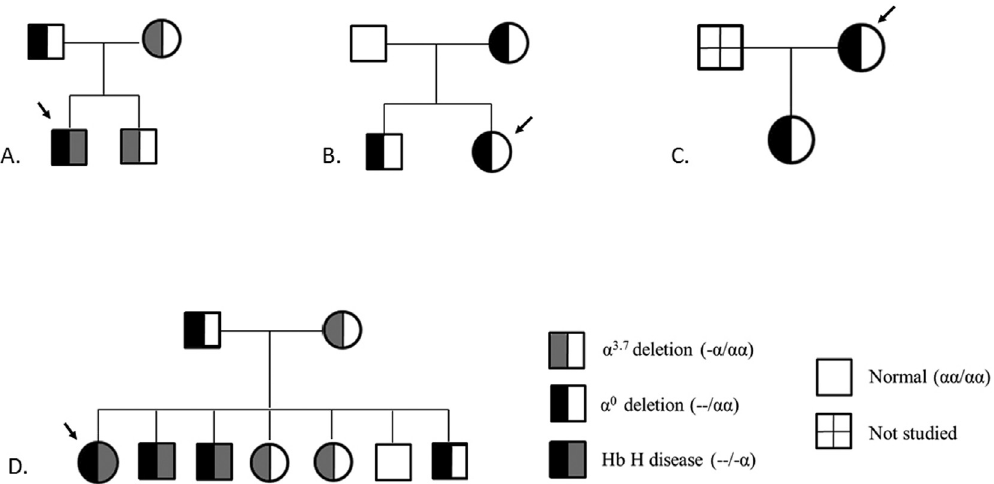
Figure 2 - Pedigrees of the families studied. (A) P1 has Hb H disease (- (cid:2) 3.7 and (cid:2) 0 alleles), while his mother and brother are heterozygous for the - (cid:2) 3.7 de- letion and his father for the (cid:2) 0 deletion. (B) P2 and her mother and brother are heterozygous for the (cid:2) 0 deletion, while her father has normal (cid:2) -genotype (no deletion). (C) P3 and her daughter are heterozygous for the (cid:2) 0 deletion. (D) P5 and two of her brothers have Hb H disease (- (cid:2) 3.7 and (cid:2) 0 alleles); her motherandtwosistersareheterozygousforthe- (cid:2) 3.7 deletion,whileherfatherandoneofherbrothersareheterozygousforthe (cid:2) 0 deletion.Onlyoneofthe siblings does not have any deletions.